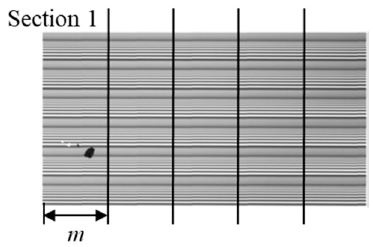
Figure 11. Block image divided into sections with width m pixels.